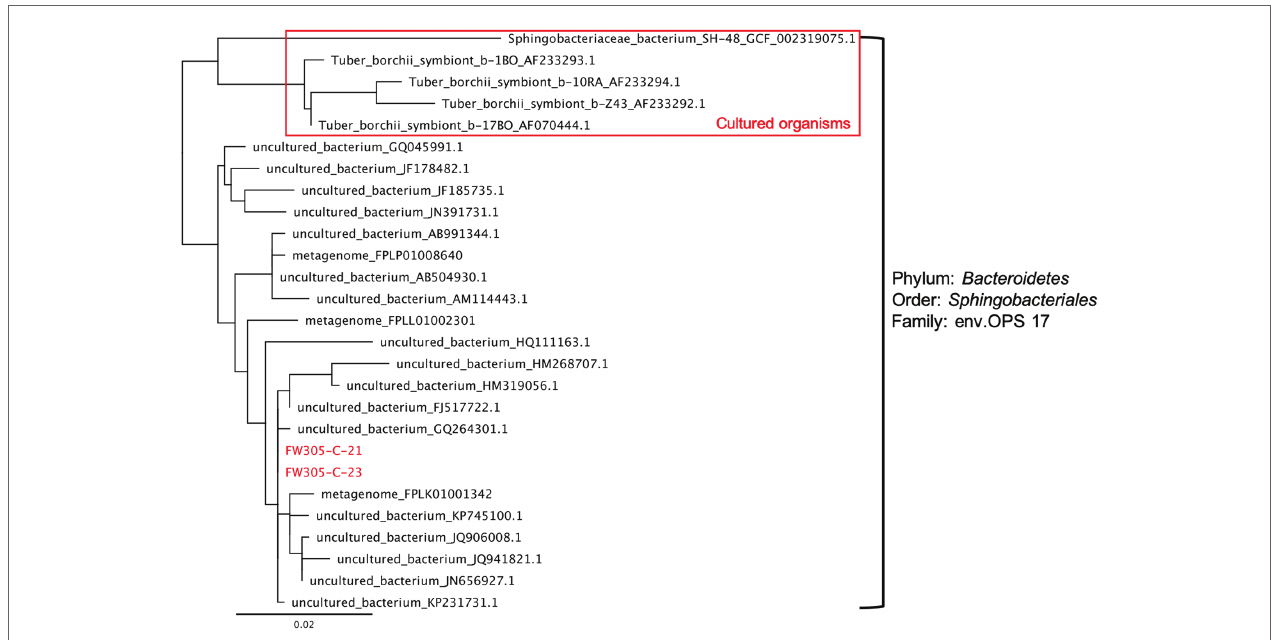
FIGURE 6 | Phylogenetic tree of the isolates FW305-C-21, FW305-C-23, and the most similar bacteria based on 16S rRNA genes. Scale bar indicates a change of 0.02 per nucleotide. The 16S rRNA gene sequences were aligned using SINA against the SILVA alignment, and the maximum likelihood tree was calculated using RAxML. The top five organisms are as far cultured organisms within this